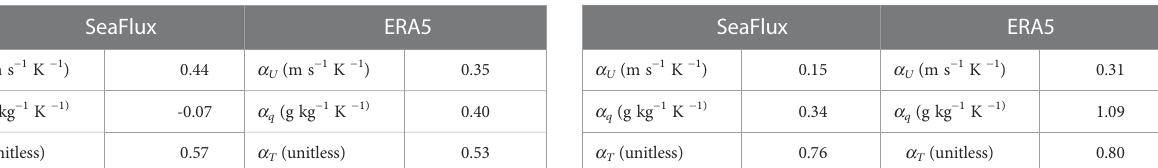
TABLE 3 As in Table 2 but for the ECR.